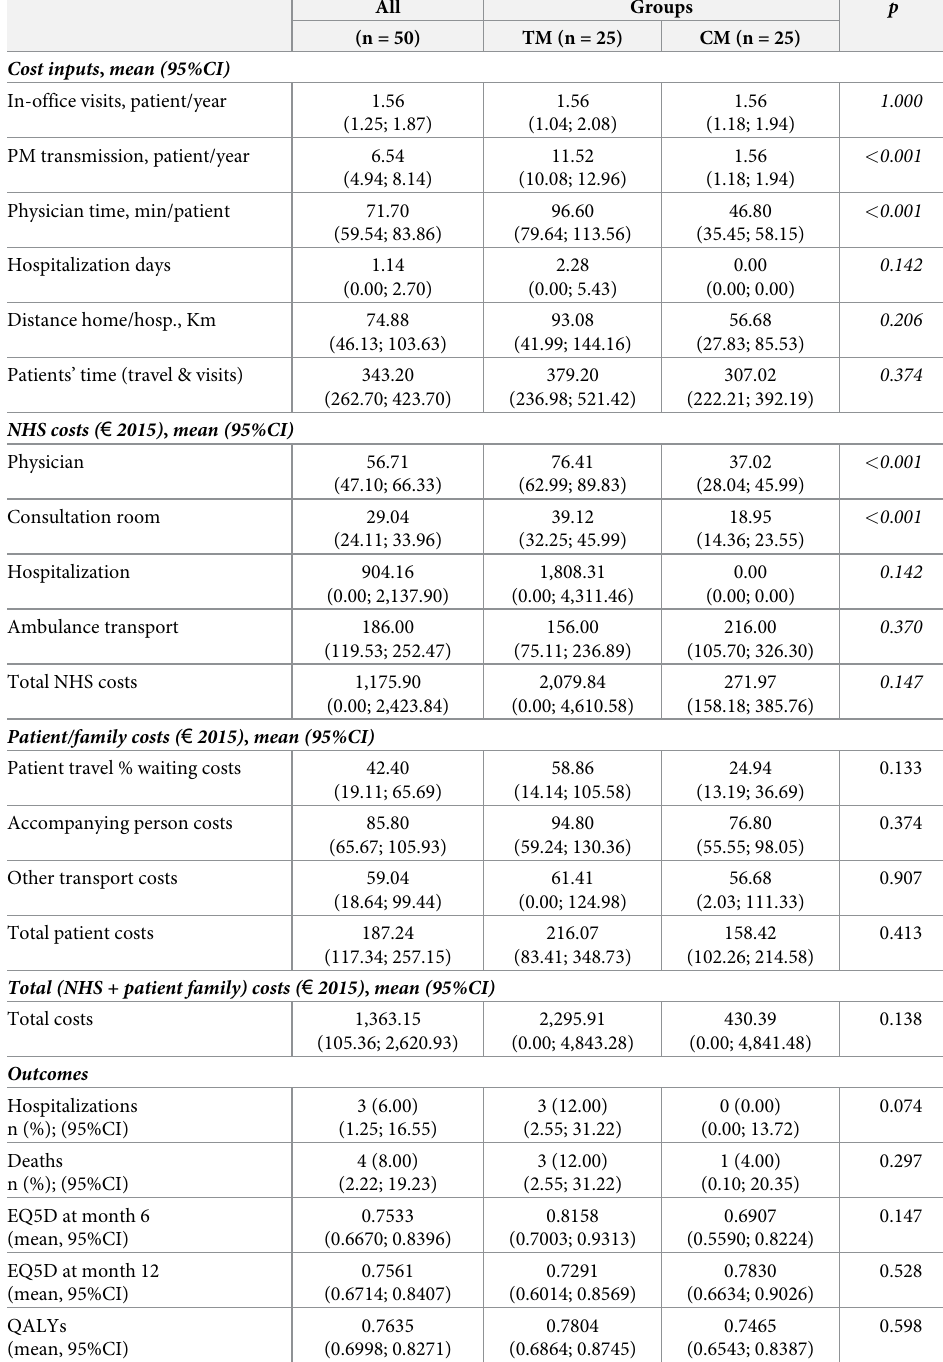
Table 2. Cost inputs, costs per patient year, and quality of life outcomes. All